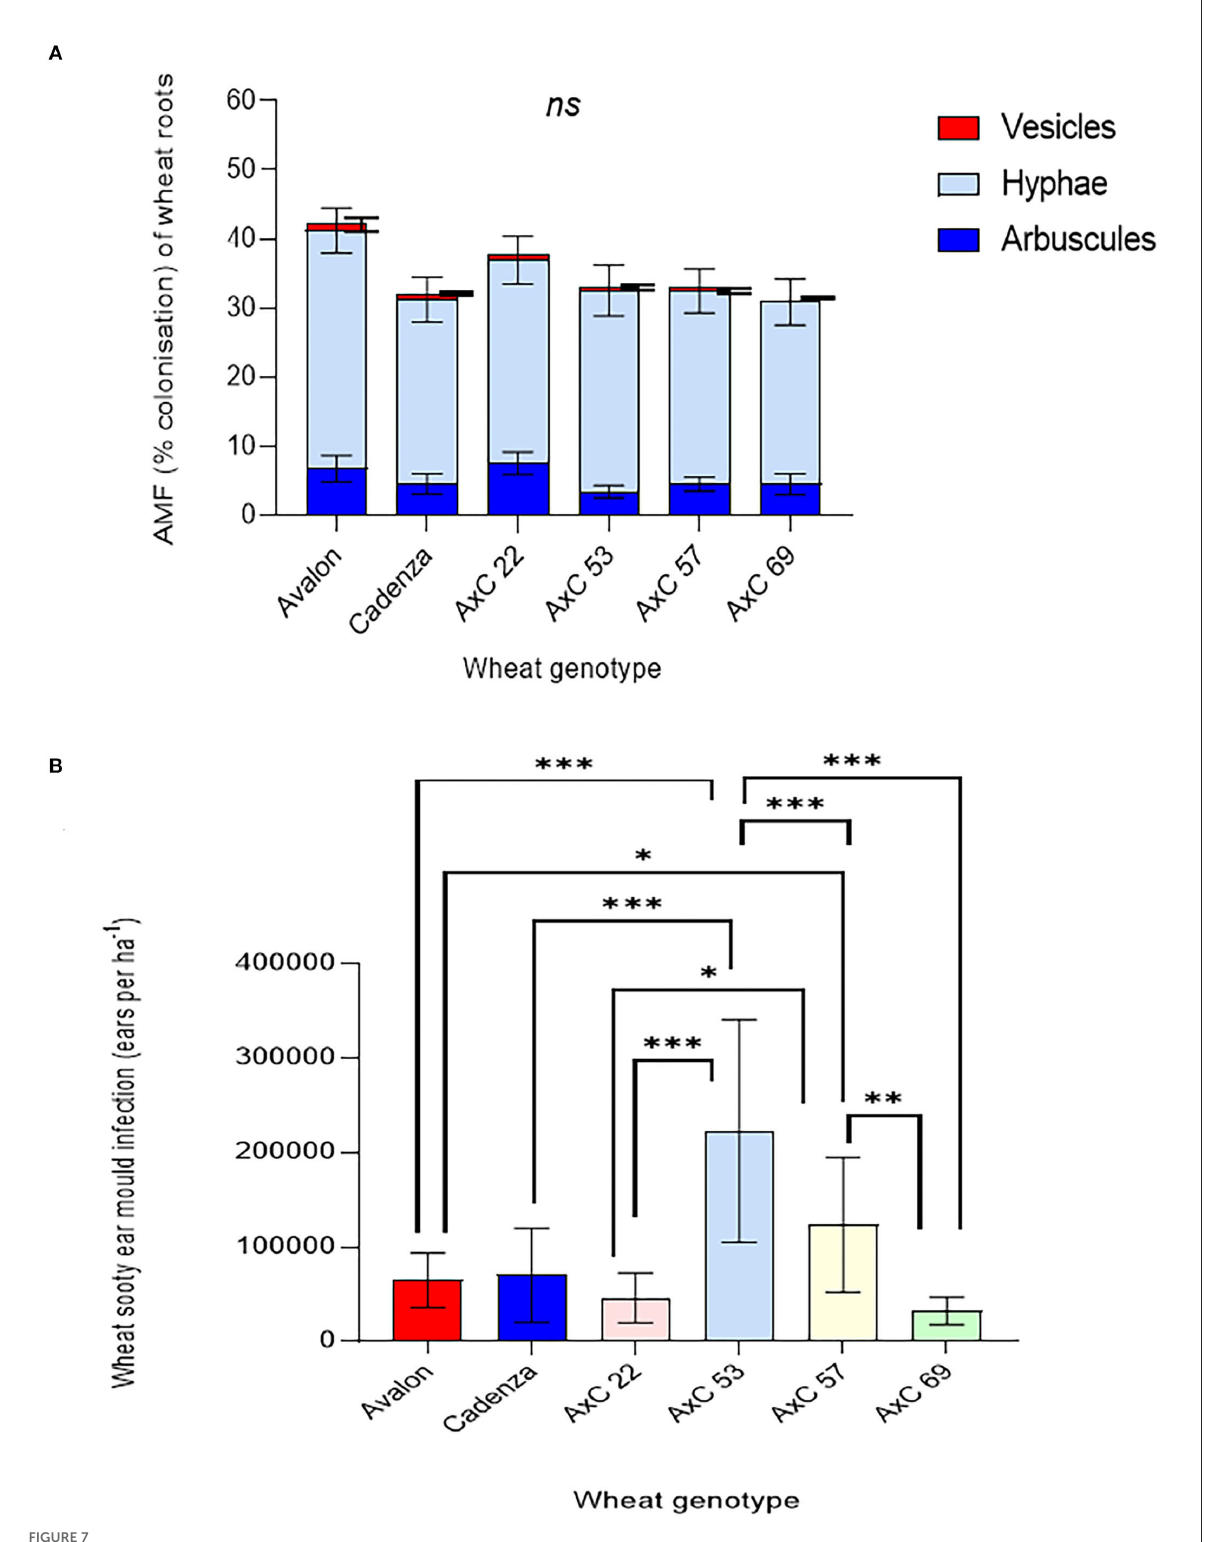
FIGURE7 Genotype effects of wheat lines Avalon, Cadenza, AxC22, AxC53, AxC57, and AxC69 on (A) Mycorrhizal abundance (% colonisation of wheat roots by hyphae, arbuscules, and vesicles) and (B) Sooty ear mould (infected ears ha − 1 ) ( n = 20 for each wheat genotype). The error bars show ± 1 SE. Results of Tukey’s HSD test results of significant differences are shown on the graphs (* p = 0.05; ** p = 0.001; *** p < 0.0001